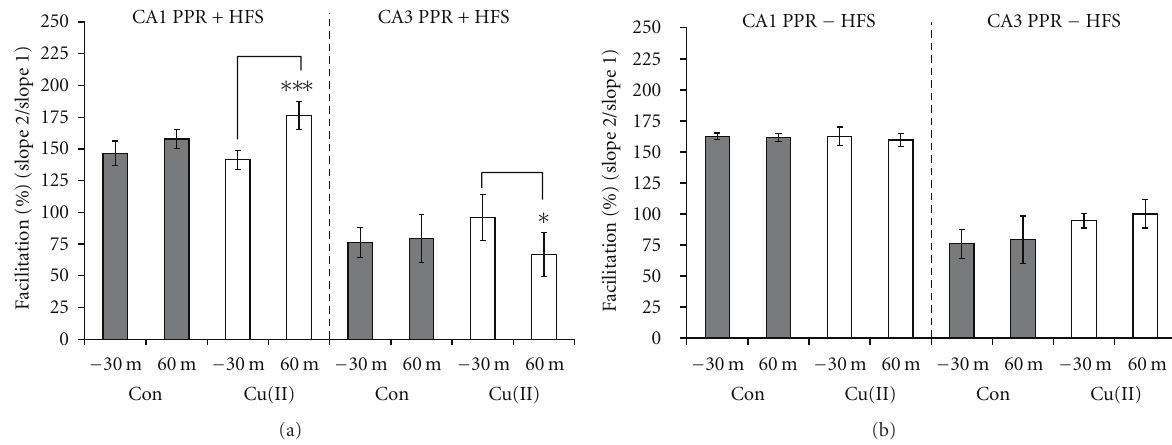
Figure 3: Modulation of the PPR by copper in the CA1 and CA3 regions was dependent on LTP. (a) The average of the PPRs measured 30 minutes before tetanizing the slices was not di ff erent in copper-treated (white bars), compared to control slices (gray bars) in either the CA1 or CA3 region. Also, the PPRs in control slices did not change after LTP in either brain region. However, after LTP, copper-treated slices showed a 34.9% enhancement of the PPR in the CA1 region ( P < 0 . 001, n = 8) and a 29.3% decrease in the PPR in the CA3 region ( P = 0 . 05, n = 8). (b) Without the HFS, there was no significant change in the PPRs compared between control and copper-treated slices in either the CA1 or CA3 region.